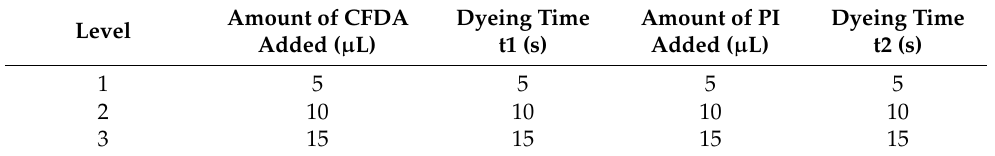
Table 1. Orthogonal experimental factor level table of dye addition and dyeing time.